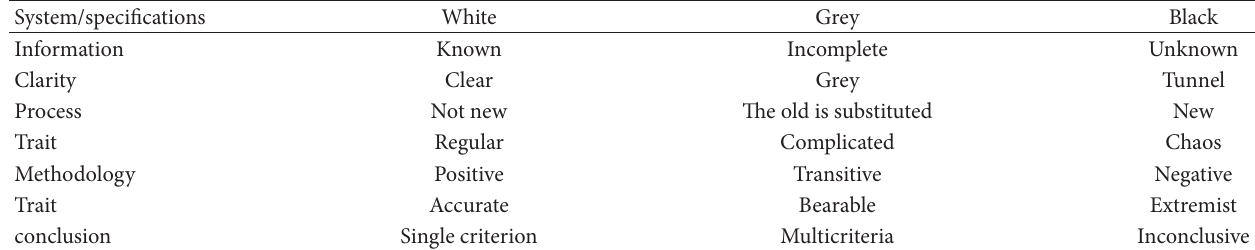
Table 2: The concept of black, grey, and white